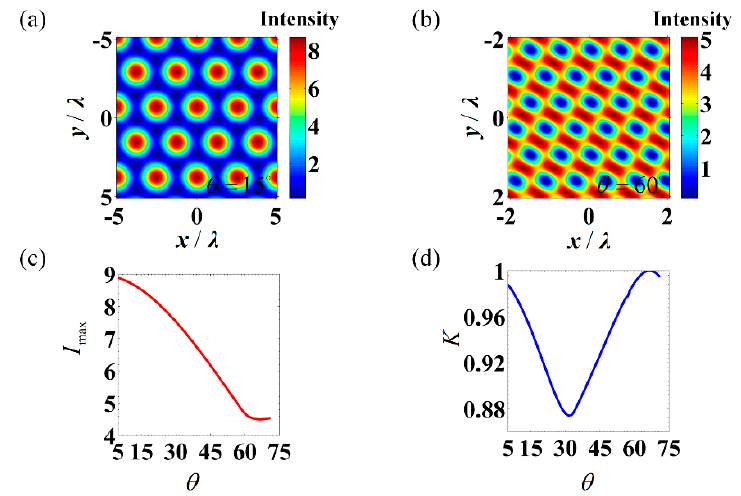
Figure 7. The interference of the three beams incident with the maximum co-directional TE polarization. The light field intensity distribution at different incident angles: the maximum value of the light field intensity changes with the incident angle and the relationship between the contrast and the incident angle. ( a ) The intensity distribution of the light field with an incident angle equal to 15°. ( b ) The intensity distribution of the light field with an incident angle equal to 60°. ( c , d ) The maximum value of the light field intensity and the contrast change due to the incident angle.